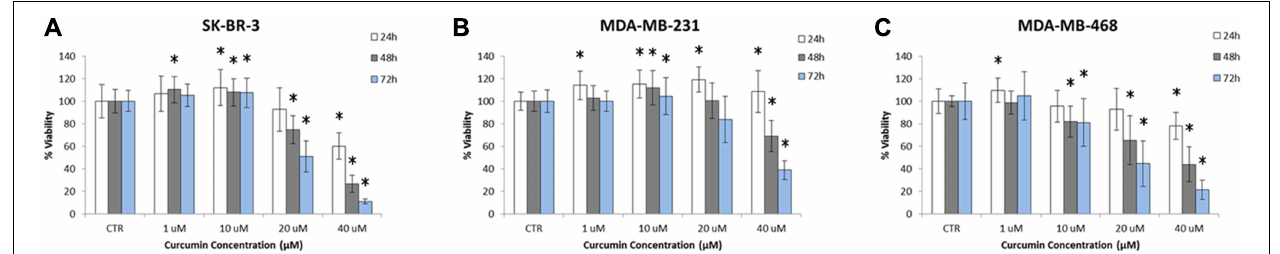
FIGURE 3 | Proliferation of (A) SK-BR-3, (B) MDA-MB-231, (C) MDA-MB- 468 cells exposed to different concentrations of curcumin (1, 10, 20, and 40 μ M) at three time points (24, 48, and 72 h). Note that cell proliferation is